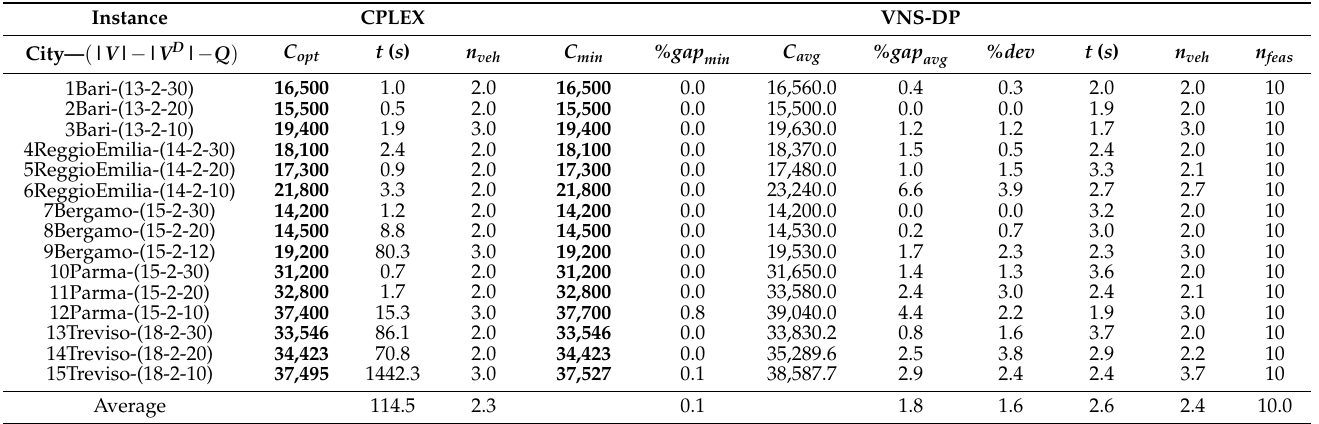
Table 4. Results for small-size benchmark instances.